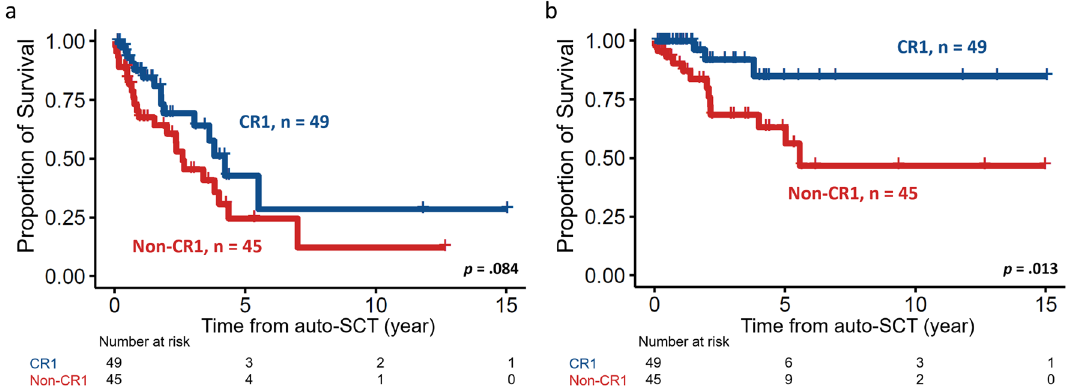
Figure 3. Kaplan–Meier plots stratified by disease status before autologous stem cell transplant. ( a ) PFS and ( b ) OS of patients with different disease status before receiving transplant. Patients receiving transplant at their CR1 state had better PFS and OS.